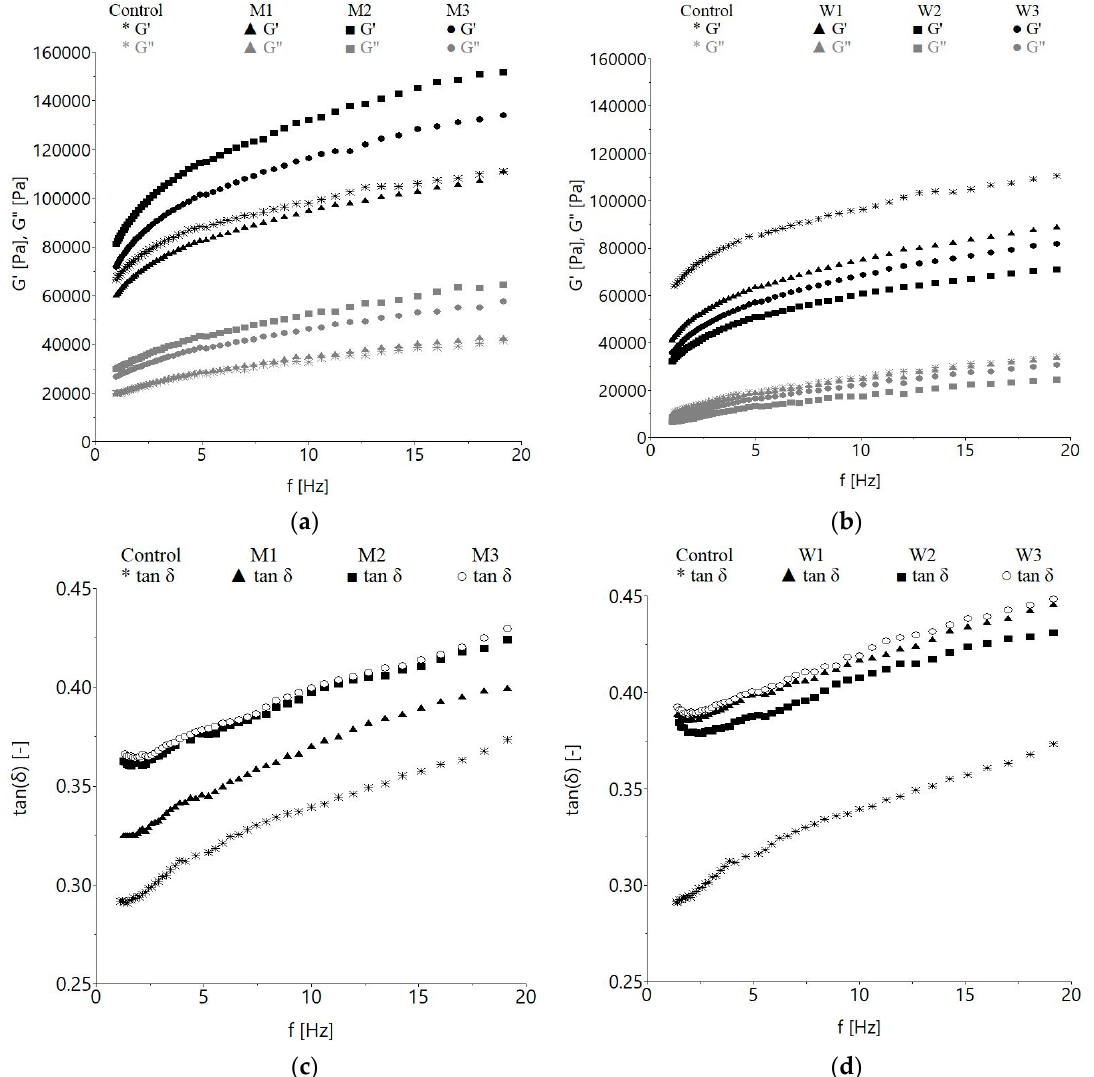
Figure 1. Storage ( G’ ) and loss modulus ( G” ) variations with frequency for: ( a ) milk containing samples, ( b ) acid whey containing samples. Loss tangent ( tan δ ) variation with frequency for: ( c ) milk containing samples, ( d ) acid whey containing samples. M1—12.5% milk, M2—25% milk, M3—50% milk, W1—12.5% acid whey, W2—25% acid whey, W3—50% acid whey.